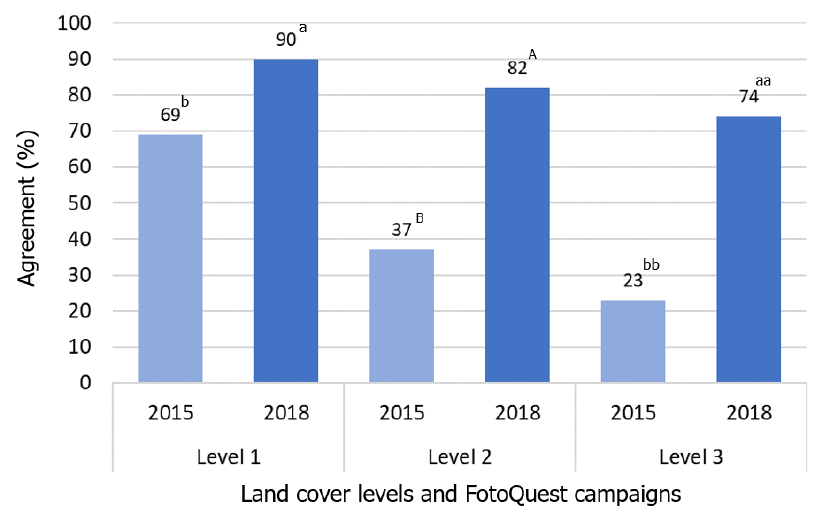
Figure 5. Comparison of percent agreement between LUCAS and FotoQuest for the 2015 and 2018 campaigns. Different letters show significantly different likelihoods of agreement per level (chi square test).